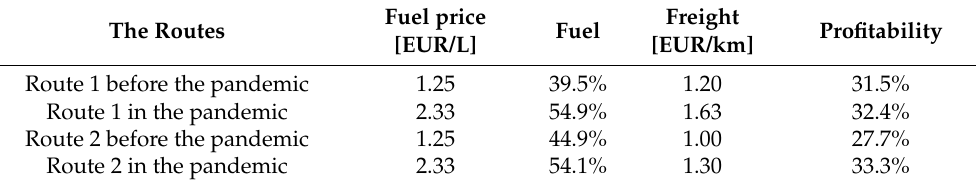
Table 6. Impact of pandemic on costs and rentability.